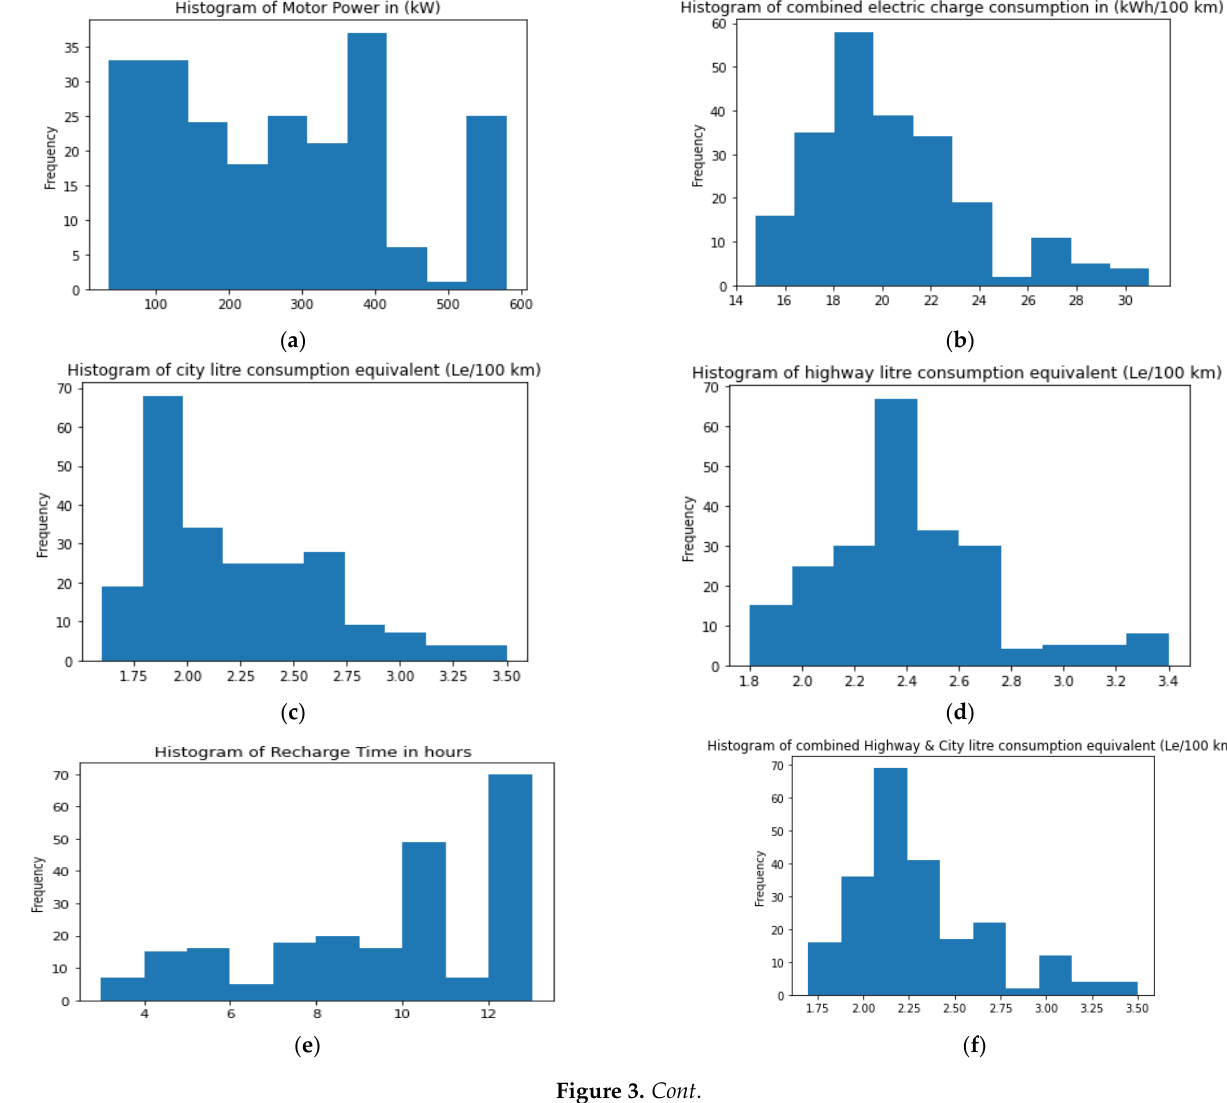
( h ) ( i ) Figure 3. Dataset visualization. ( a ) Motor Power; ( b ) Combined electric charge consumption; ( c ) City litre consumption equivalent; ( d ) Highway litre consumption equivalent; ( e ) Recharge Time; ( f ) Combined (highway and city) consumption equivalent; ( g ) City electric charge consumption; ( h ) highway electric charge consumption; ( i ) Range. 2.2.5. Formation of the Proposed Model for PEV To build or form the DANN model, a Python library known as Keras was imported and used for this process. The phases of model formation are described below. • Selection of Model Parameters Using eight variables as inputs and one as the target variable, and Keras library in Python, the model was built. The details of the model formation are shown in Figure 4. The input layer consists of eight variables. It is represented by dim = 8. The 1st hidden layer consists of 100 nodes, kernel initializer (normal), and activation function (ReLu). The duty of an activation function is to transform its inputs into outputs within a certain range. The 2nd hidden layer consists of 50 nodes, kernel initializer (normal), and activation func- tion (tanh). Tanh activation function is a hyperbolic function. It takes the input as the real value and squash it to a range of − 1 and +1. Larger inputs are closer to 1 and smaller ones tend to − 1. Output layer consists of one node and a kernel initializer. The kernel initializer, which is normal of x, takes the negative function as 0.